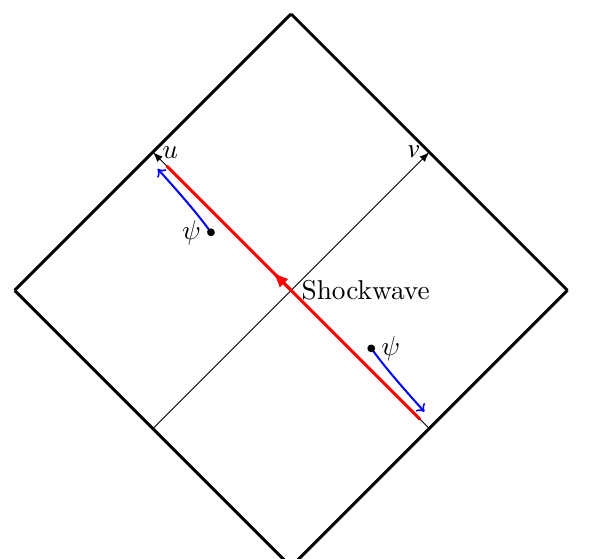
Figure 5 . The Regge limit: the operator product ( u; v ) ( (cid:0) u; (cid:0) v ) can be replaced by a shockwave propagating along v = 0 when (cid:1) (cid:29) 1